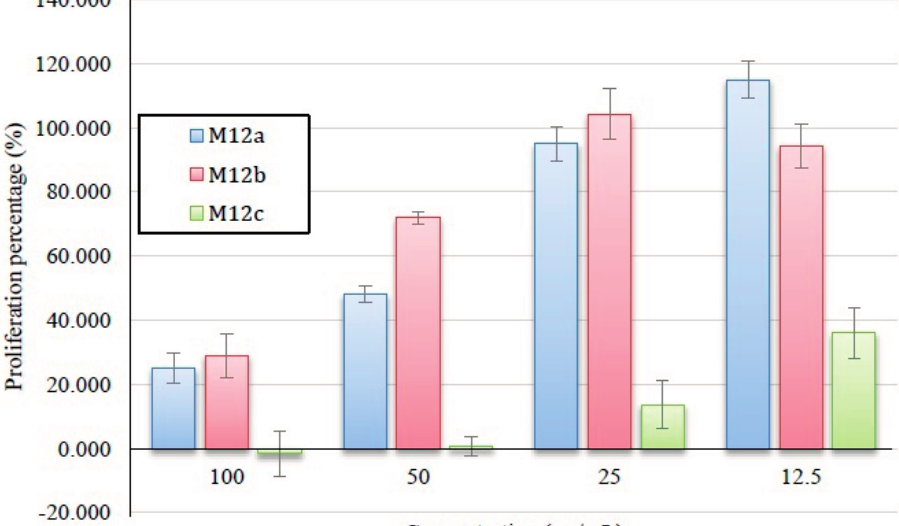
Figure 8. Antiproliferative activity of M12 sub-fractions. All values represent mean of triplicate determinations ± standard deviation. Control cell cultures were incubated with DMSO (0.5%), which represented 100%